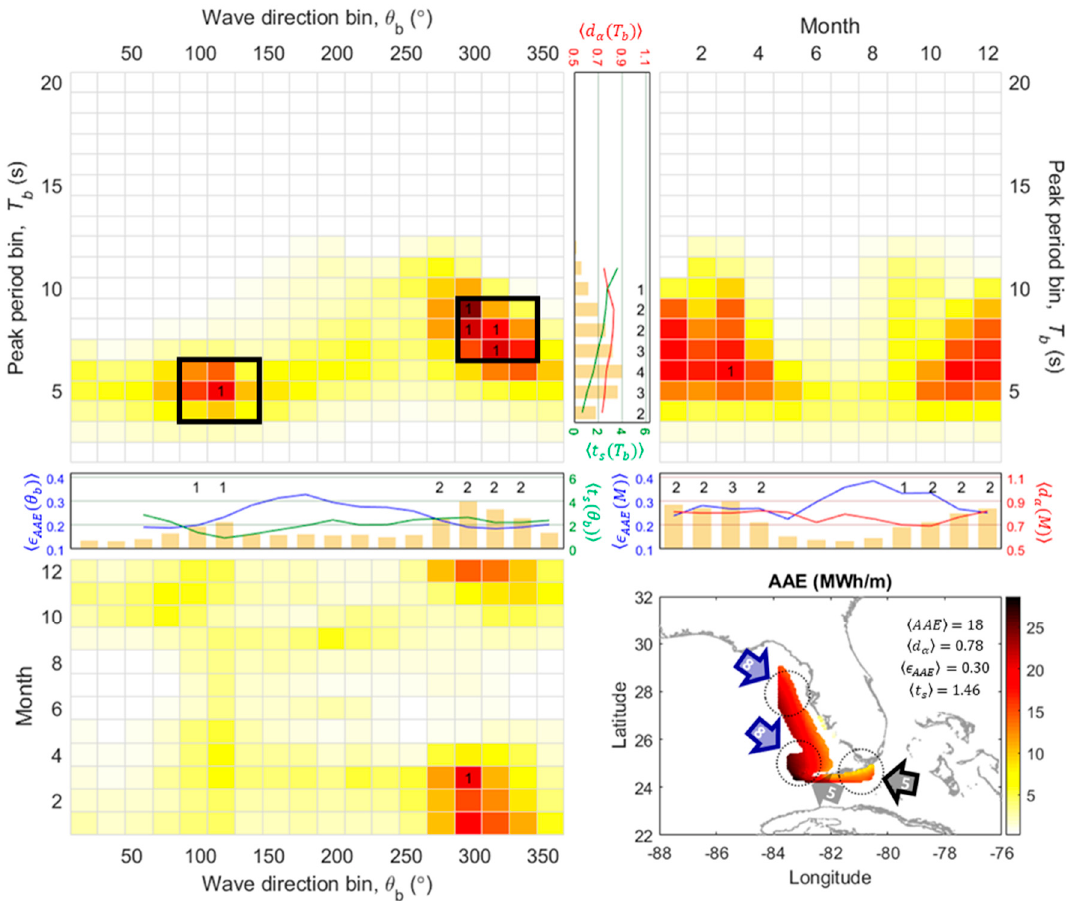
Figure 9. [Region 8: Gulf of Mexico—Eastern Coast] The detailed descriptions are identical to Figure 2. As relative contributions from the two dominant wave systems vary for each sub-region, a thinner box (secondary dominant wave system) is blended with the bold box (most dominant wave system) in the (cid:10) (cid:11) AAE ( T b , θ b ) .